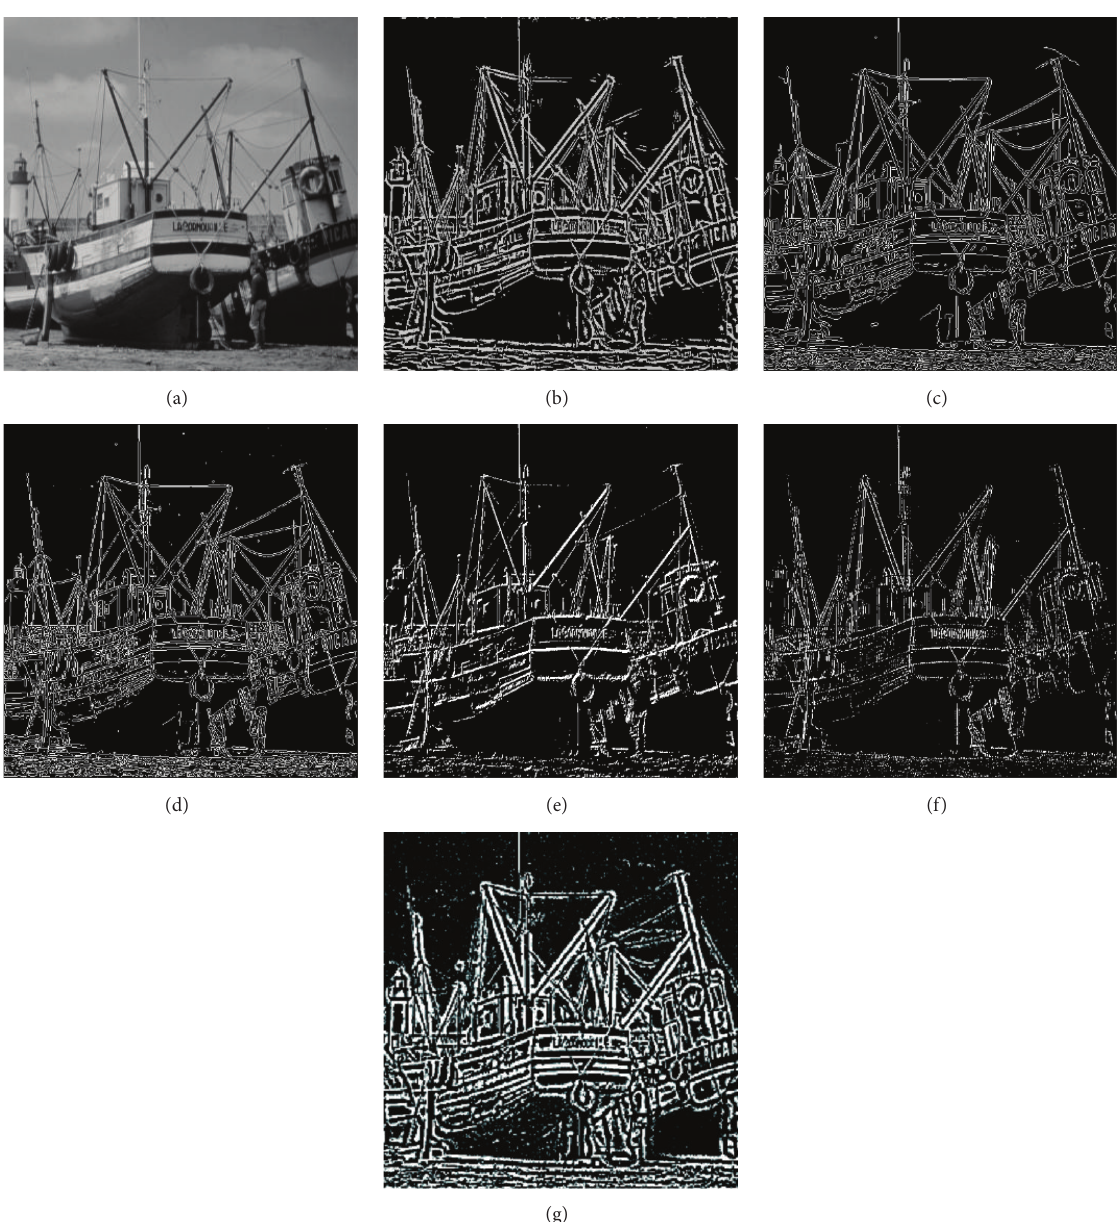
Figure 7: Edge detection results: (a) original image; (b) the result by Canny; (c) the result by our method; (d) the result by Sobel; (e) the result by wavelet method; (f) the method based on CNN; (g) NSCT